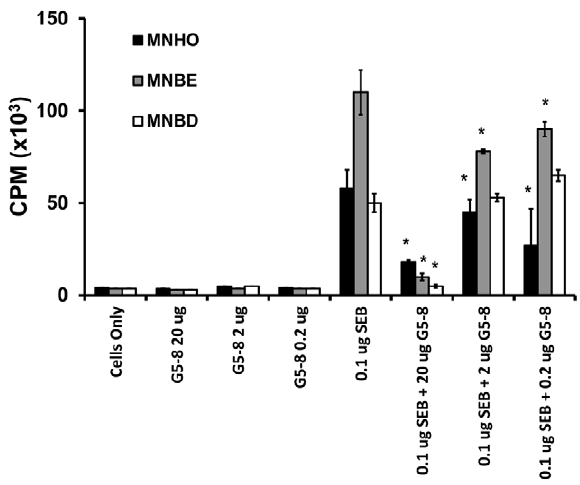
Figure 4. Variant SEBs differ in their abilities to cause proliferation of human lymphocytes. Human PBMCs were exposed to varying concentration of SEB from strains MNHO, MNBD, or MNBE, and subsequently incubated with 3 H-thymidine. Cellular proliferation is reported as the measure of the counts per minute of 3 H-thymidine that had incorporated into the DNA of the PBMCs. The mitogenicity of each toxin was measured in quadruplicate. The three toxins caused different patterns of monocyte proliferation. Error bars represent the standard deviations, and statistical significance was determined by using Student’s unpaired t -test. *, P , 0.05 with respect to MNHO; 1 P , 0.05 with respect to MNBE; # , P , 0.05 with respect to MNBD.